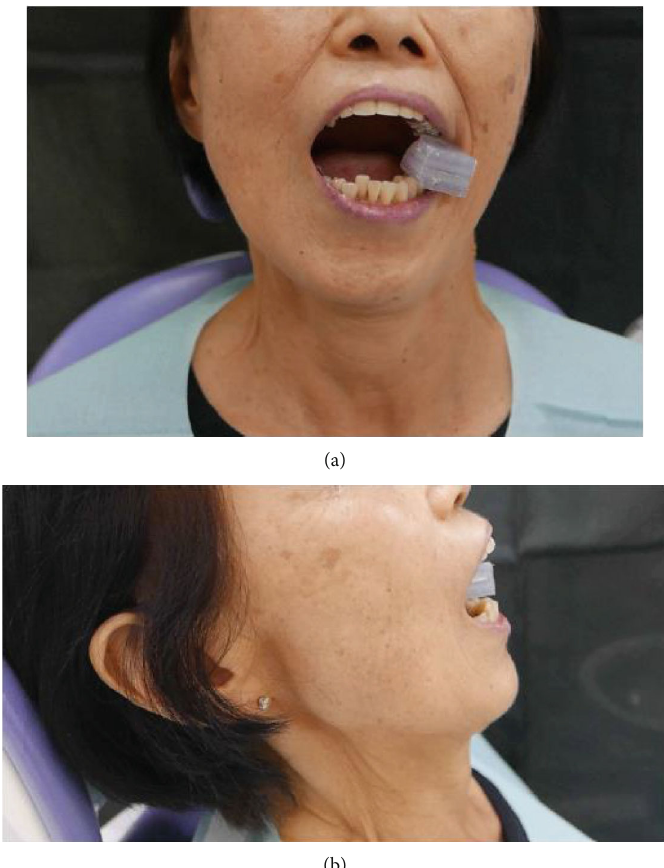
Figure 5: Mouth-opening training with the device. (a, b) The patient received instructions on how to insert the device and advance it in the direction of the